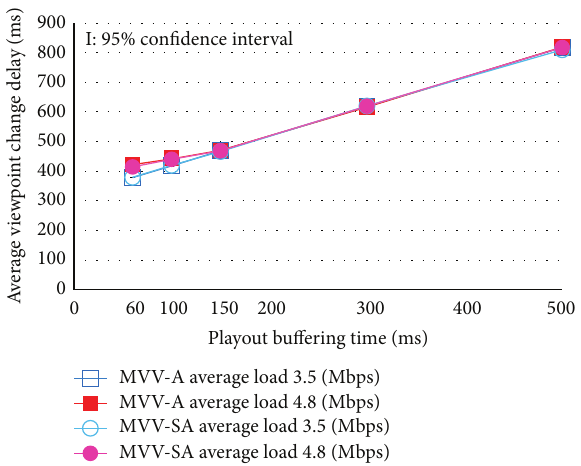
Figure 8: Average viewpoint change delay: additional delay 150ms.